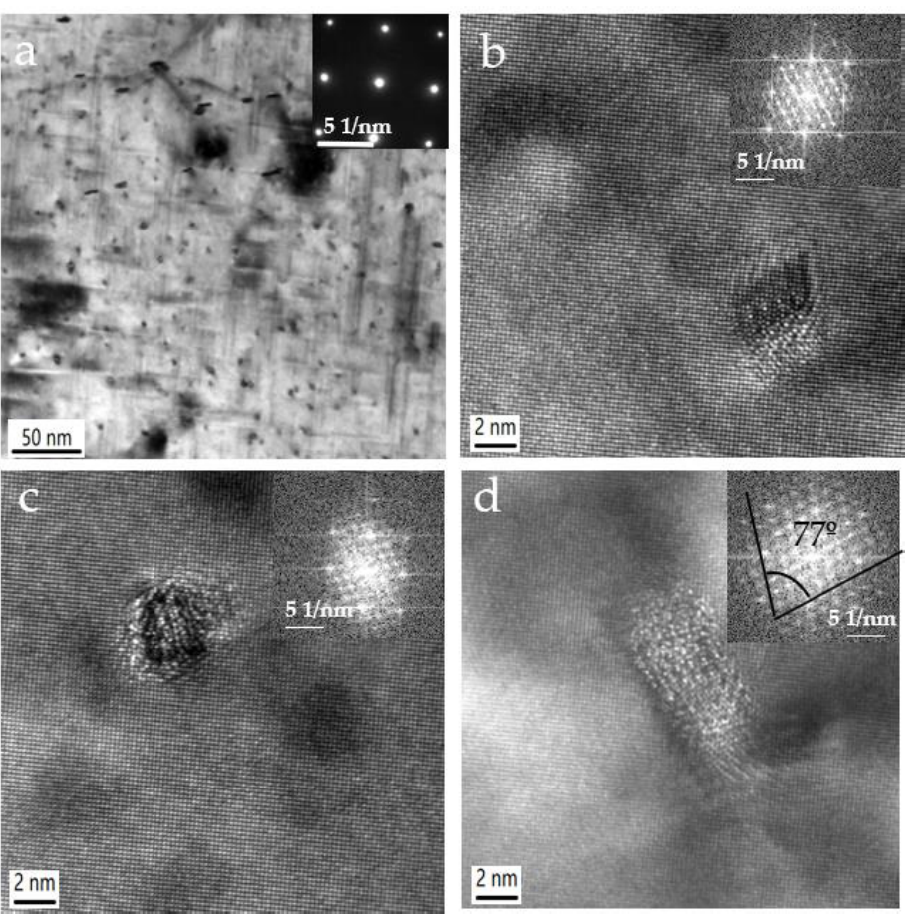
Figure 4. ( a ) Bright-field TEM images of the as-solutionized alloy aged at 180 °C for 3 h with zone axis [001] Al , ( b – d ) the HRTEM images of a cross-section of precipitates and the Fast Fourier transform of the HRTEM image.